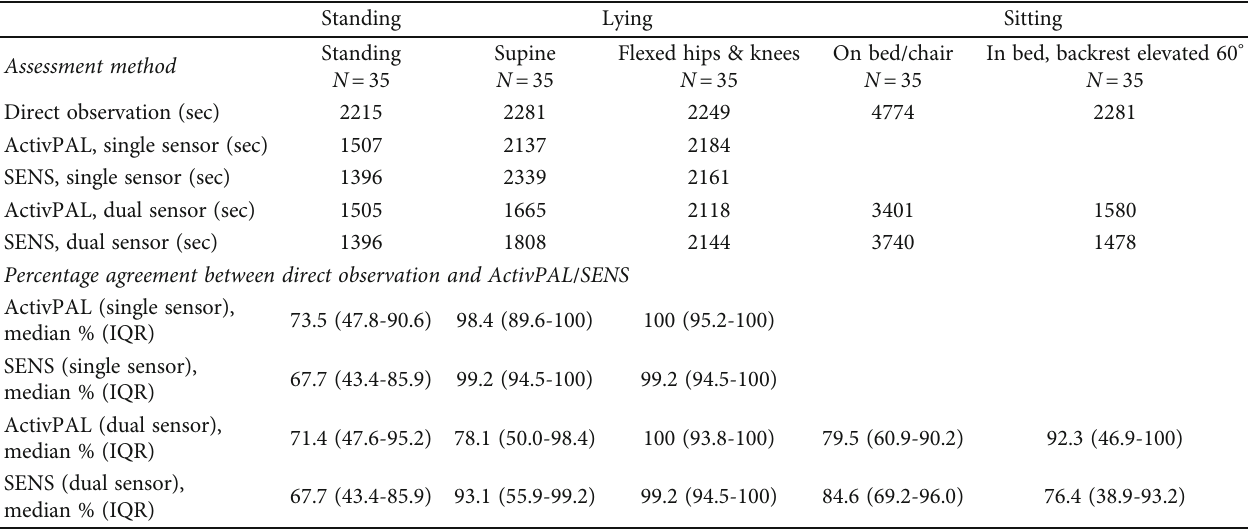
Table 4: Agreement between standing, sitting, and lying measured by direct observations and by ActivPAL3 ™ and SENS motion® used as both single- and dual-sensor systems. Standing Lying Sitting Assessment method